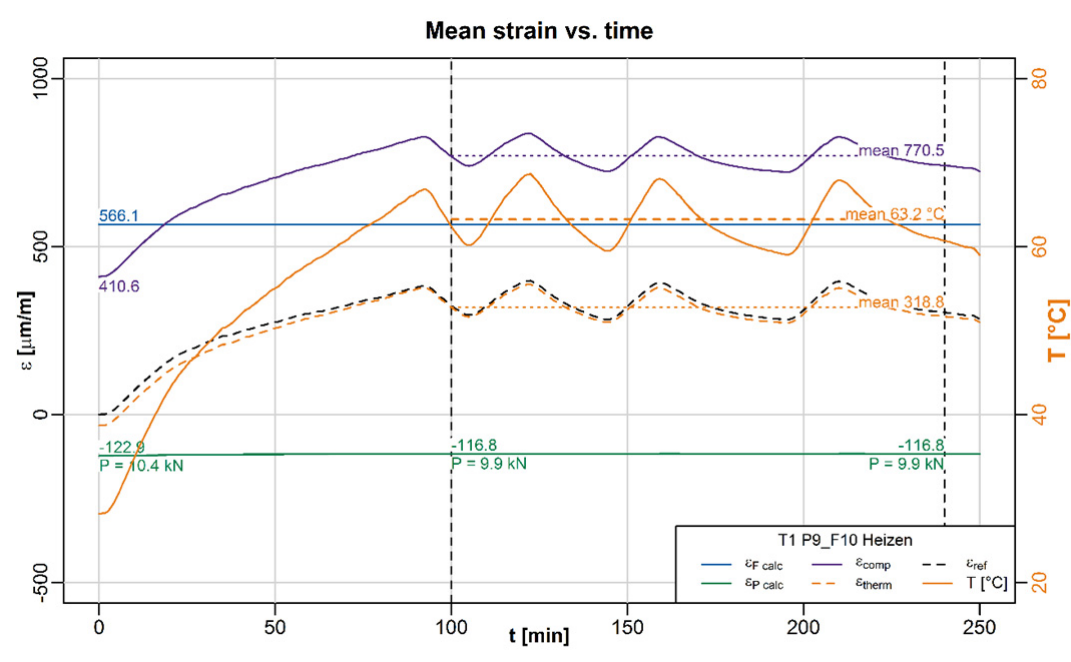
Fig. 10 Thermal and mechanical strain for specimen (I) P9_F10.